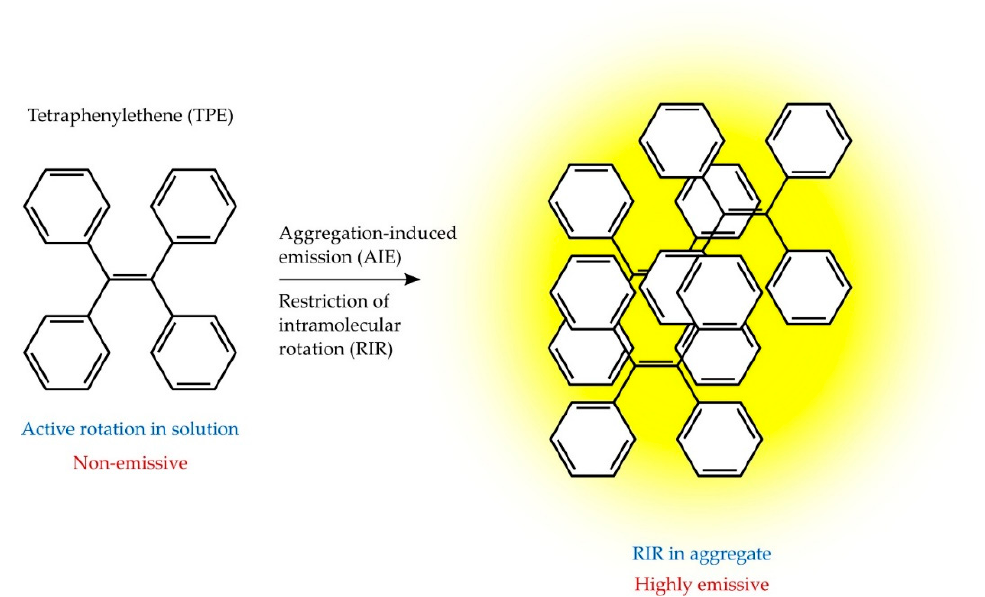
Figure 2. Scheme of the principle of aggregation-induced emission.